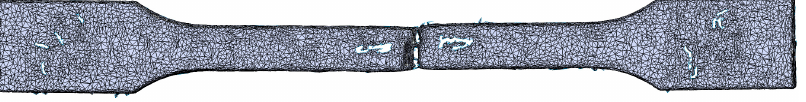
Table 3. Averaged dimensions of simulation model of tested samples with Composite Layup.